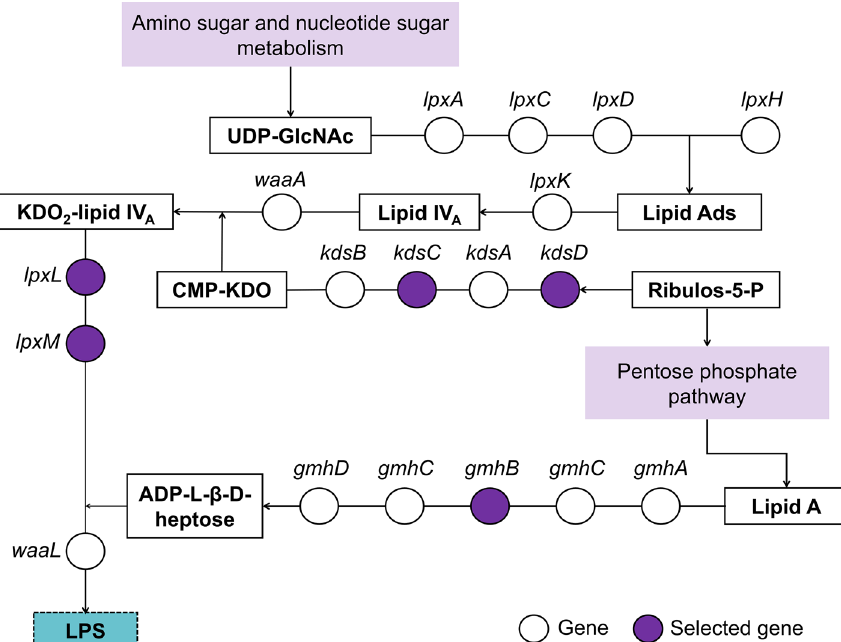
Figure 2. Schematic location of the five selected genes ( lpxL, lpxM, kdsC, kdsD , and gmhB ) in the lipopolysaccharide (LPS) metabolism pathway. UDP-GlcNAc, UDP-N-acetylglucosamine; Lipid Ads, Lipid A disaccharide; Lipid IVA, Lipid A disaccharide bisphosphate; KDO2-lipid IVA, Di[3-deoxy-d-manno- octulosonyl]-lipid IV( A ); CMP-KDO, CMP-3-deoxy-beta-d-manno-octulosonic acid; Ribulose-5-P, Ribulose-5- Phosphate; ADP-l-β-d-heptose,